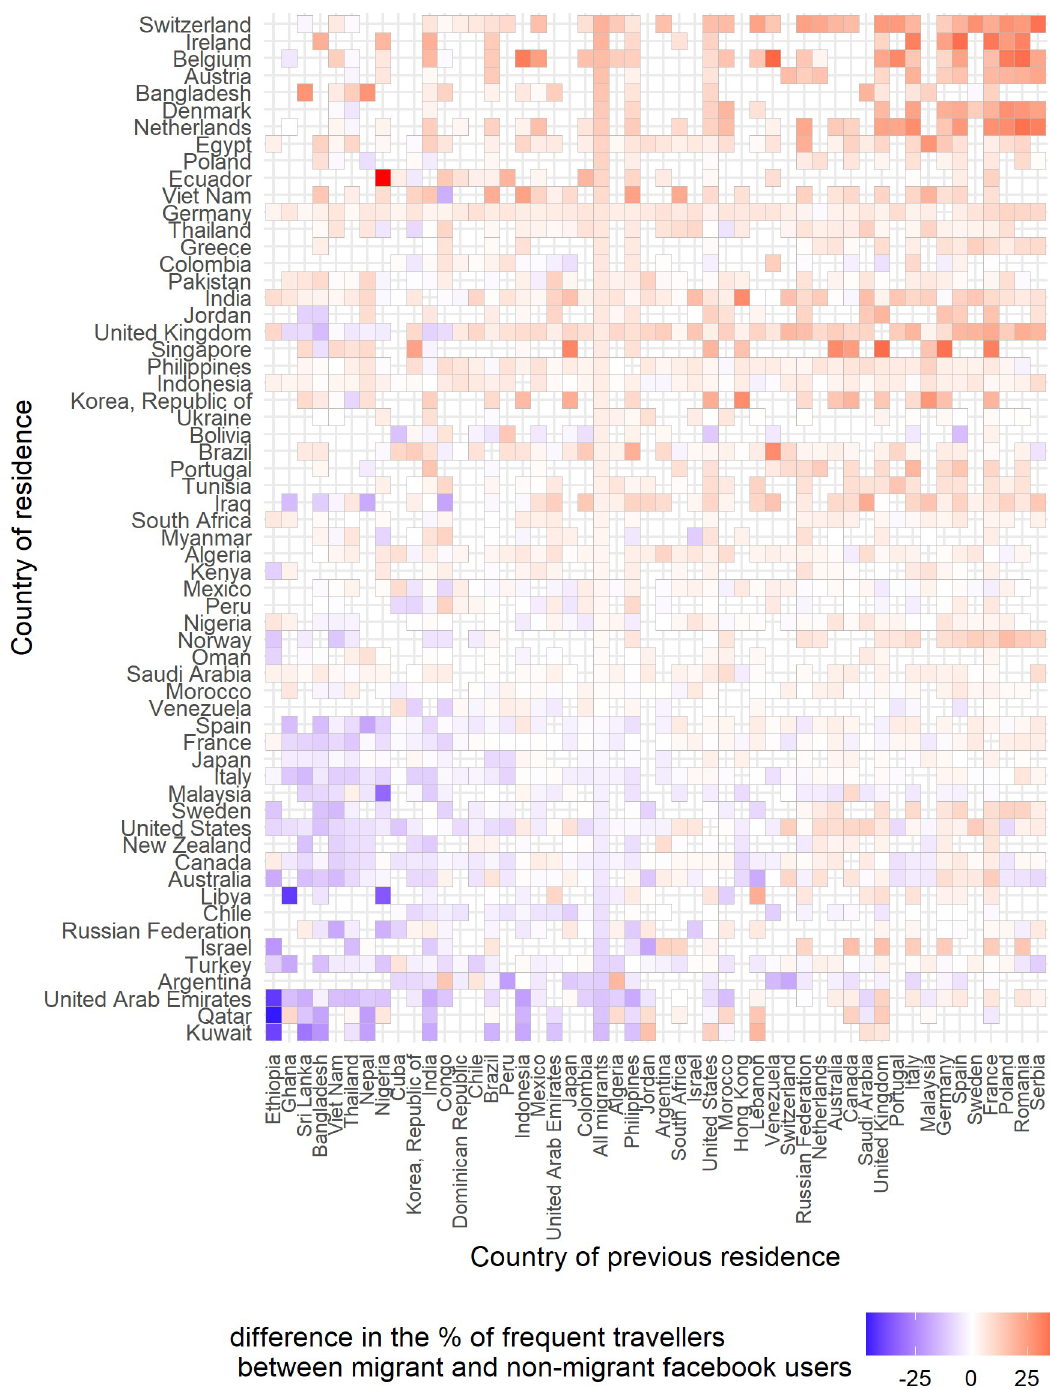
Fig 4. The heatmap of frequent travellers. The difference in the percentage of frequent travellers between Facebook migrant users and Facebook non-migrant users of age 15 to 64 for each country of residence. Empty cells mean no available data. The heatmap includes the 60 countries of residence with the highest number of migrant groups and the 50 countries of previous residence with the highest presence in the selected 60 countries of residence.